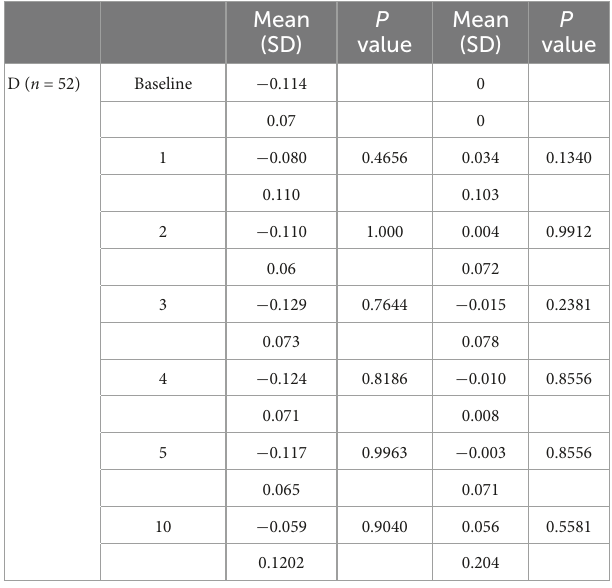
TABLE 3 LogMAR VA and changes in logMAR VA from baseline during 10 years after initiation of IFX treatment in eyes classified by decimal VA at